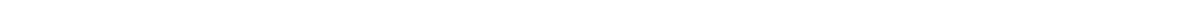
Fig. 5 H3K18cr and H3K18ac ChIP-seq on MS275-treated HCT116 cells. a Probe trendplot over TSS ( ± 10 kbp) of reads from H3K18ac and H3K18cr